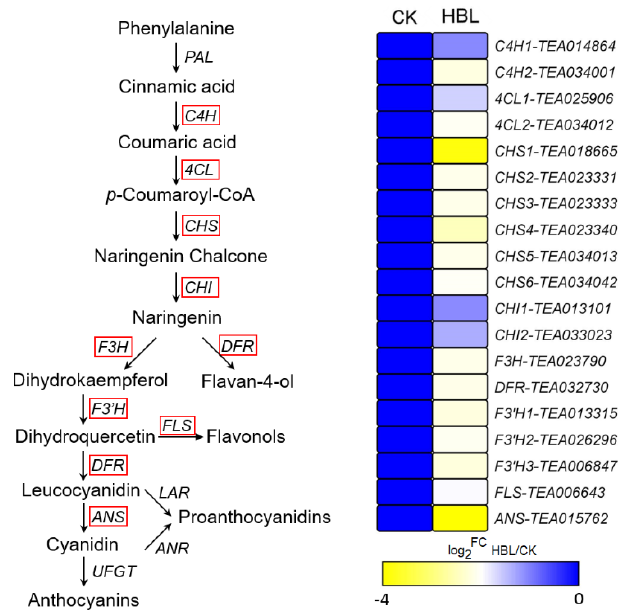
Figure 6. DEGs involved in flavonoid biosynthesis under high intensity blue light in tea plant shoots. The red line indicates the annotated DEGs. The heatmap was generated from the log 2 -fold change (log 2 FC) mean value calculated from three replicates of RNA-Seq data.